Question: Give a one-sentence summary of this figure.
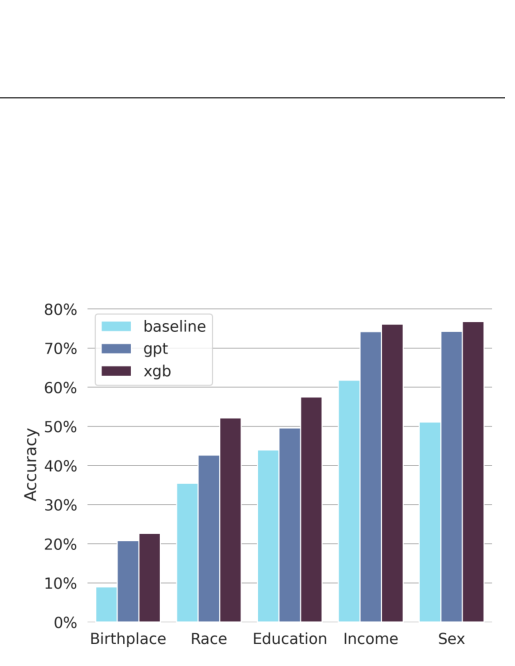
Answer: Comparison of GPT-4 prediction ac- curacy against finetuned XGB models on several ACSIncome attributes. The baseline denotes a majority class classifier.